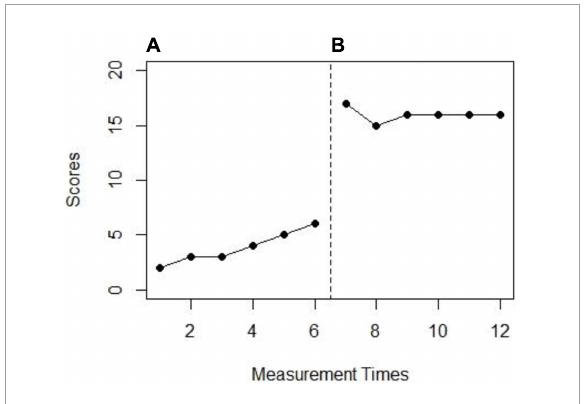
FIGURE2 Example (A,B) graph with two facets (Data characteristic: baseline trend and research question: Non-overlapping data). Research question: What is the amount of non-overlapping data between phases (A,B)